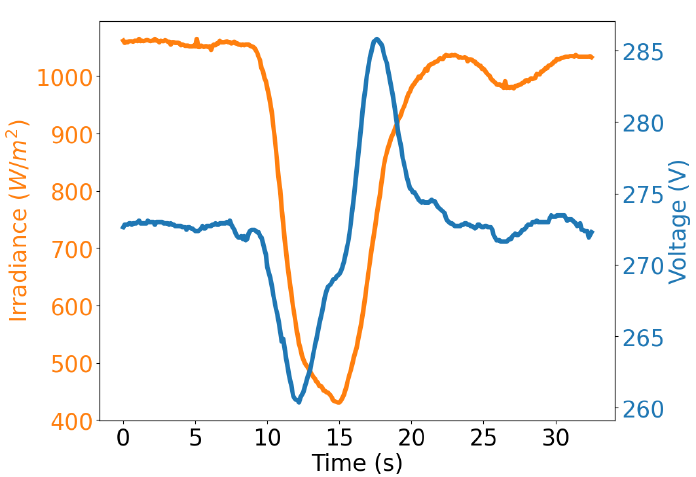
Figure 2. Cloud 1 (50.59% irradiance drop): irradiance fluctuation and corresponding system volt- age disturbance.